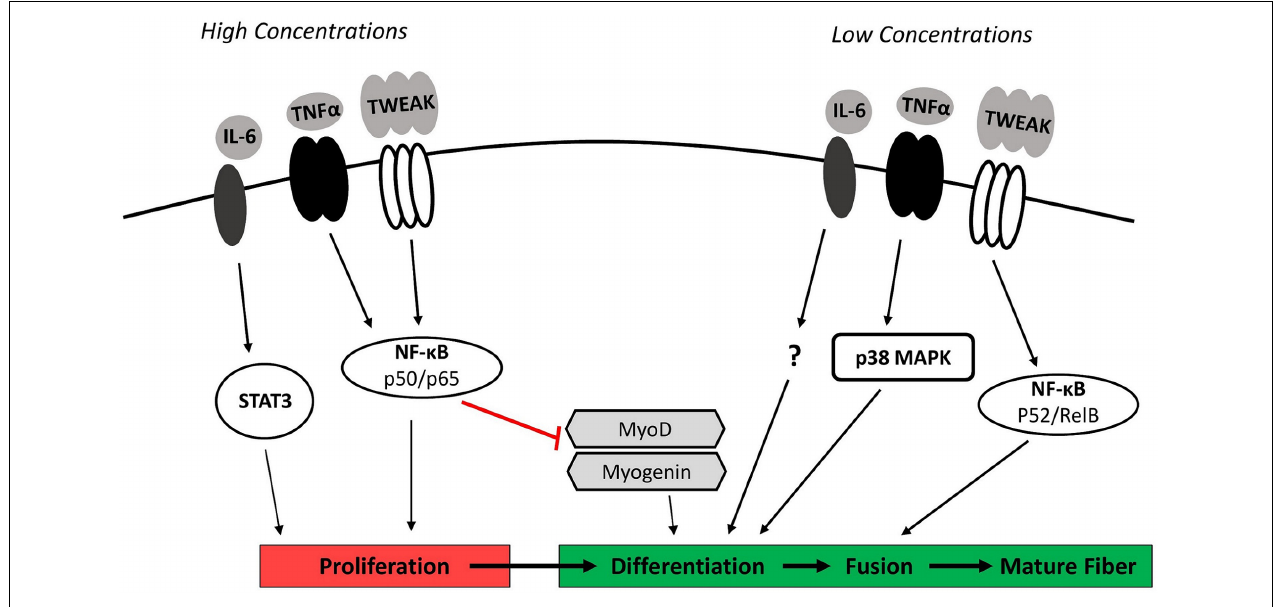
FIGURE 1 | Inflammation and myogenesis. While multiple cytokines are involved in coordinating the myogenic response to injury, major regulators include IL-6, TNF α , and TWEAK. High concentrations of these cytokines signaling via STAT3 and the classical NF- κ B pathway (p50/p65 heterodimer) stimulate myoblast proliferation but inhibit subsequent differentiation through the degradation and destabilization of the myogenic regulatory factors MyoD and myogenin. Low concentrations of IL-6, TNF α , and TWEAK signaling through p38MAPK and the alternative NF- κ B pathway (p52/RelB heterodimer) are necessary to facilitate later stages of myogenesis by stimulating myoblast differentiation and fusion. IL-6, interleukin-6; NF- κ B, nuclear factor- κ B; p38 MAPK, p38 mitogen-activated protein kinase; STAT3, signal transducer and activator of transcription 3; TNF α , tumor necrosis factor- α ; TWEAK, TNF-like weak inducer of